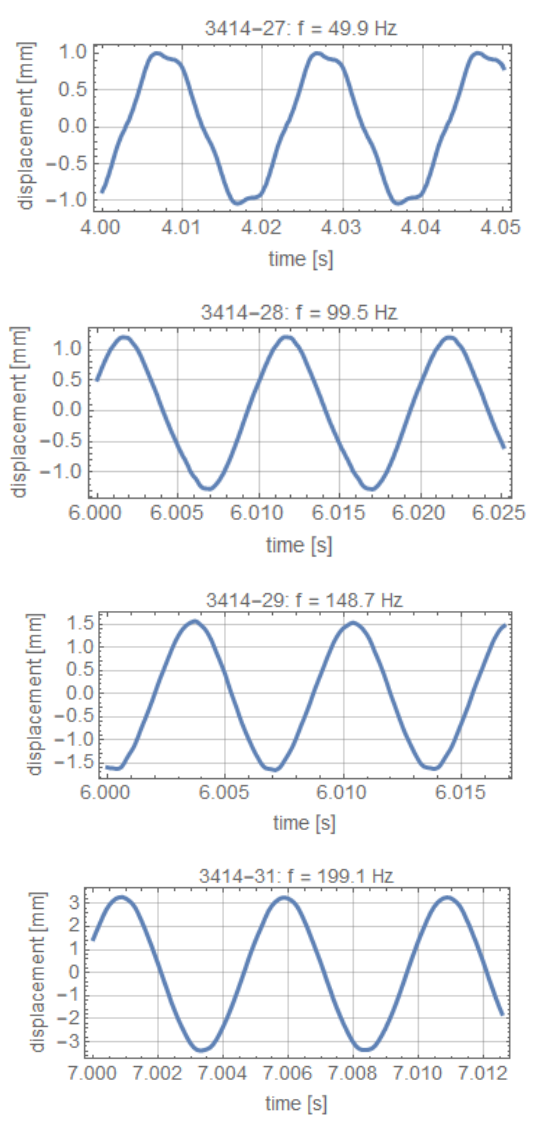
Figure Deflection of the blade leading edge during 6. oscillations in the frequency range 𝑓 = 10 − 200 Hz .